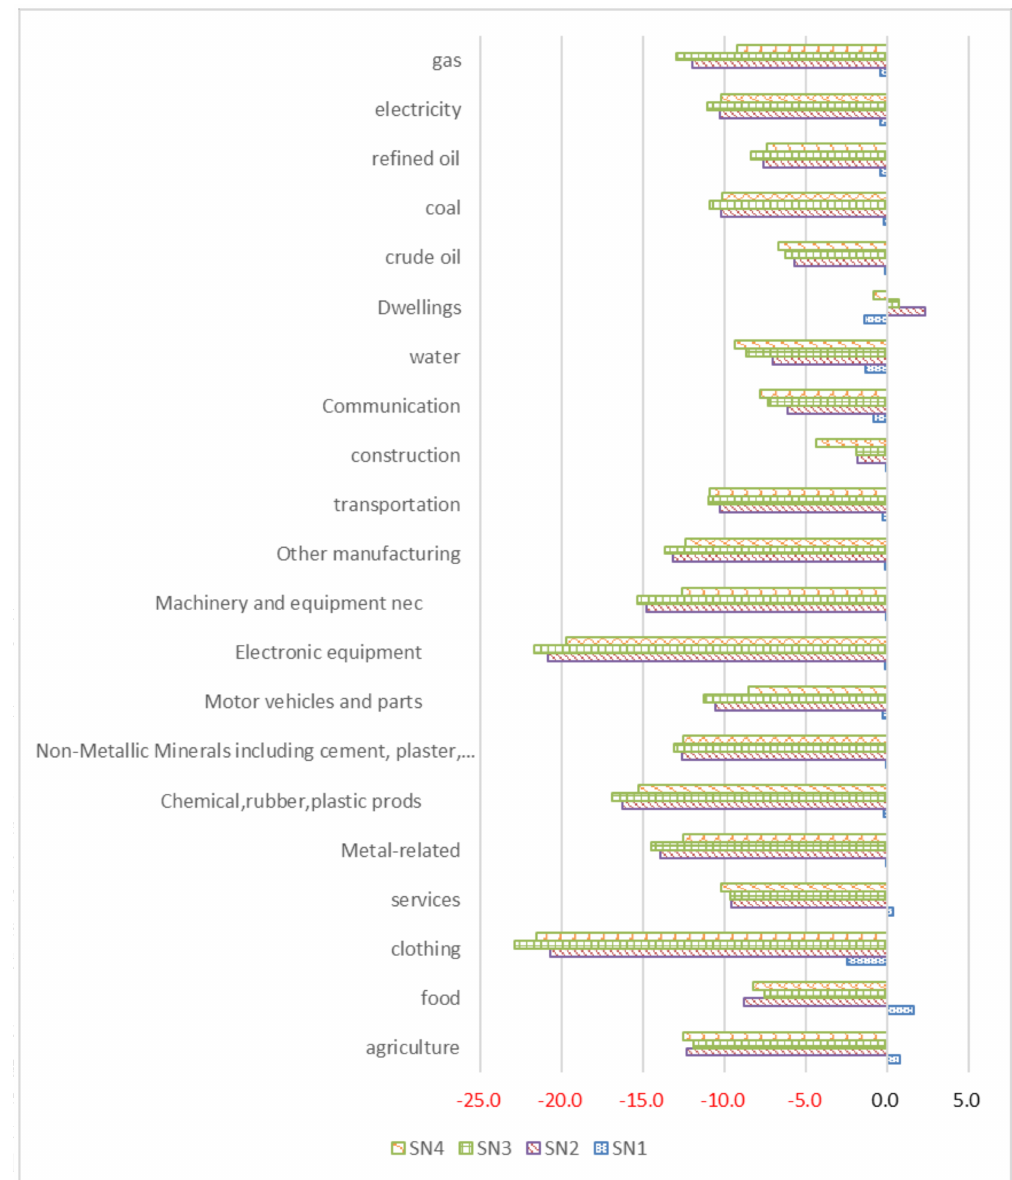
Figure 3. Sectoral production in China: Deviations from BAU. Percent. Source: The authors. In SN4, all sectors reduce activity levels compared to BAU due to additional negative ageing impact from other countries. The reduction is modified compared to SN3 for all sectors but agriculture, food, services, construction, communication, water supply, dwellings, and crude oil, indicating the ageing impact in other countries on China’s economy via international